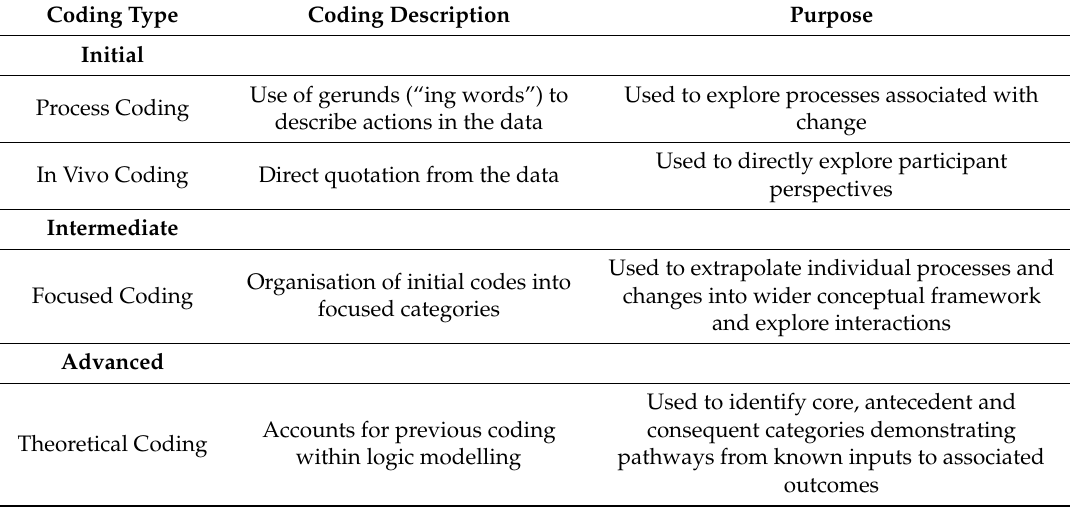
Table 1. Di ff erent kinds of coding and their purpose within